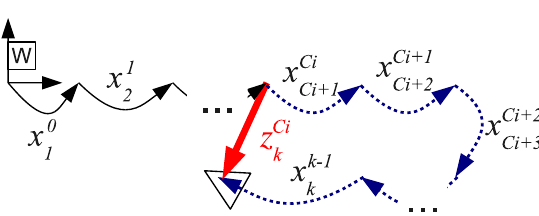
Figure 6. Illustration of a measurement (thick red arrow) and the corresponding observation function (dashed blue